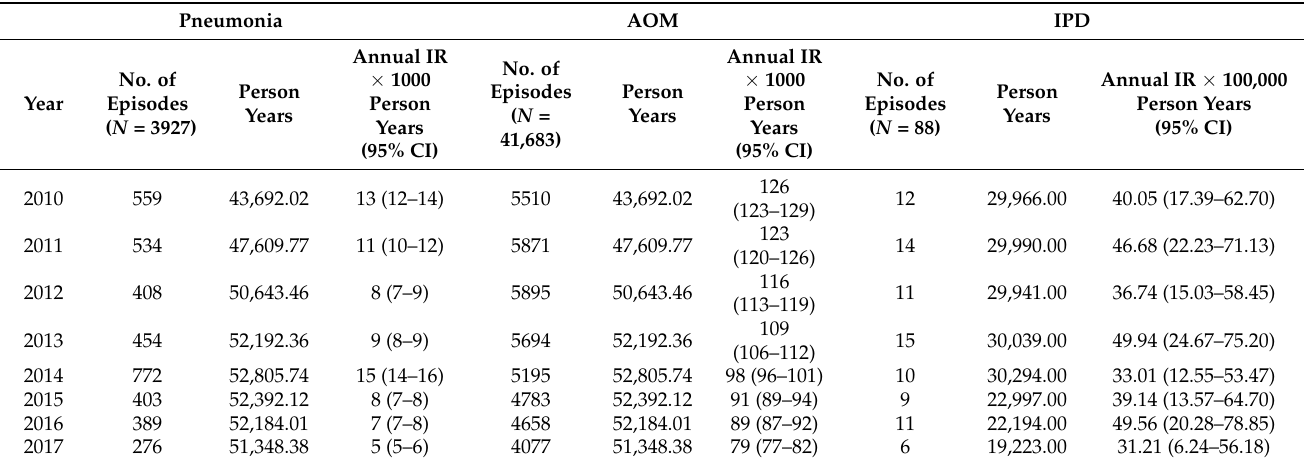
Table 2. Pneumonia, AOM, and IPD annual incidence estimates in the pediatric population < 15 years of age (Pedianet